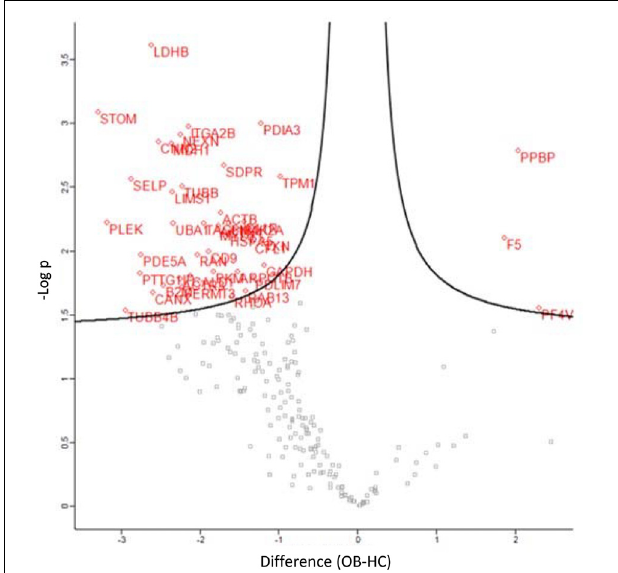
FIGURE 4 | Volcano plot displaying the 47 differential expressed proteins between obese (OB) and healthy control (HC) platelet-derived MPs; the y-axis corresponds to the mean expression value of log10 ( p -value), and the x-axis displays the difference values (OB-HC), the red dots represent the differentially expressed proteins ( P < 0.05), and the gray dots represent the proteins whose expression levels did not reach statistical significance ( P > 0.05).